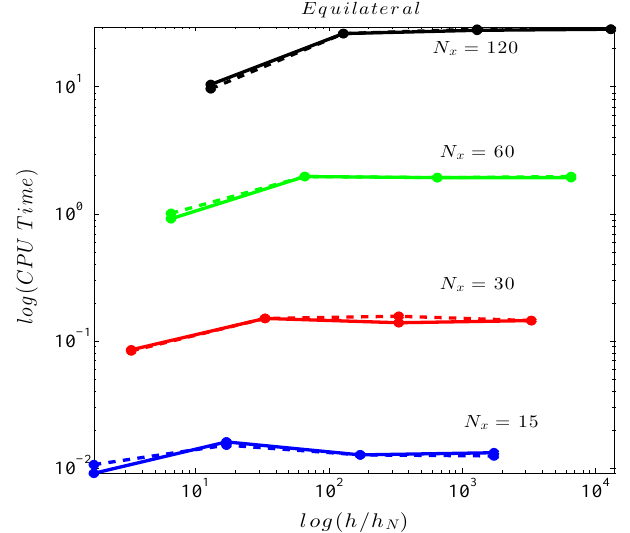
Figure 8. CPU time versus h / h N for GMRES (solid line) and BiCGStab (dashed line) applying the ILUT preconditioner with τ = 10 − 5